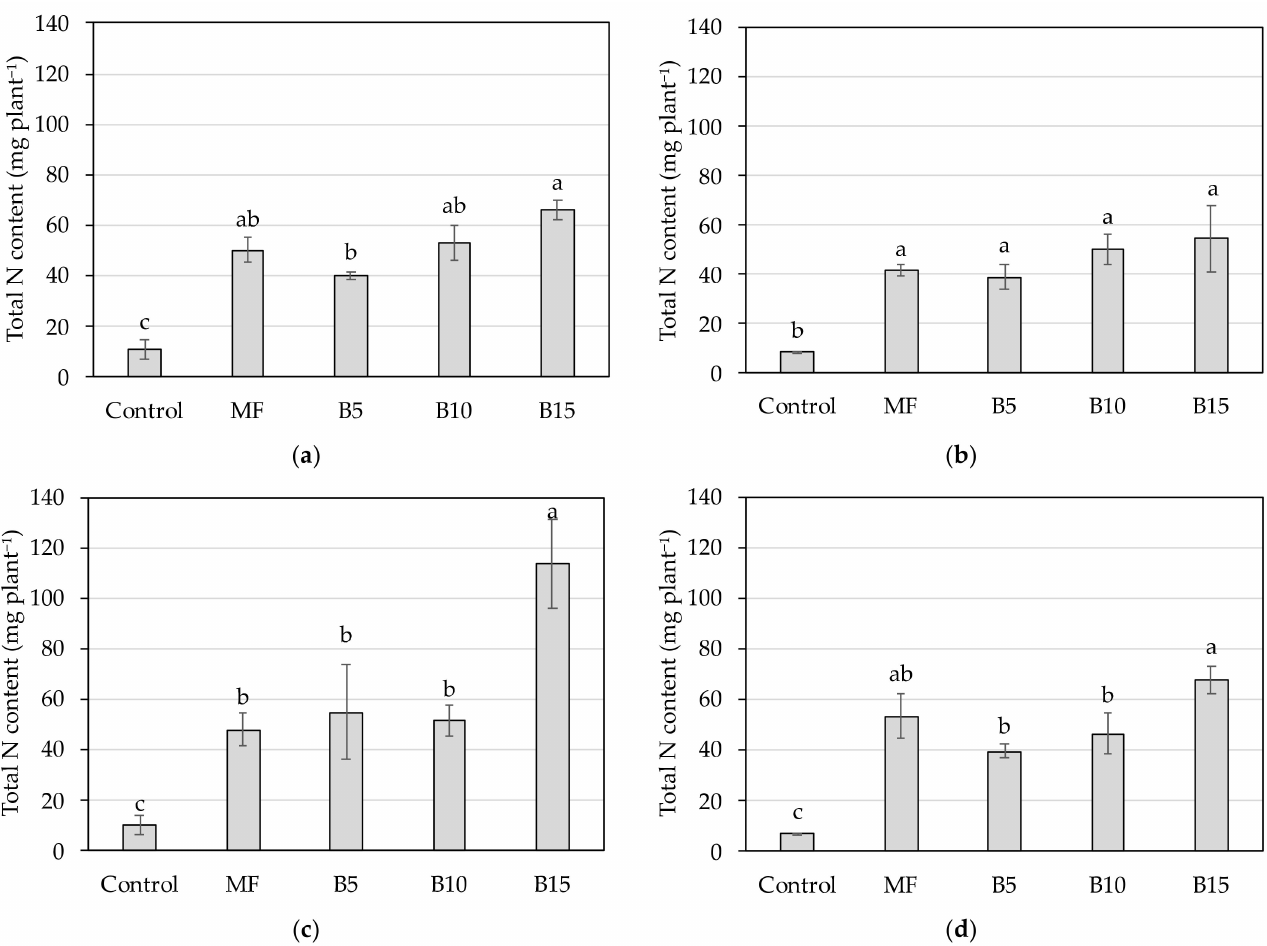
Figure 3. Total N content at flowering, as affected by fertilization treatment in: ( a ) barley; ( b ) common wheat; ( c ) durum wheat; and ( d ) oat. Bars with different letters are significantly different according to Tukey’s test ( p > 0.95). Error bars represent standard